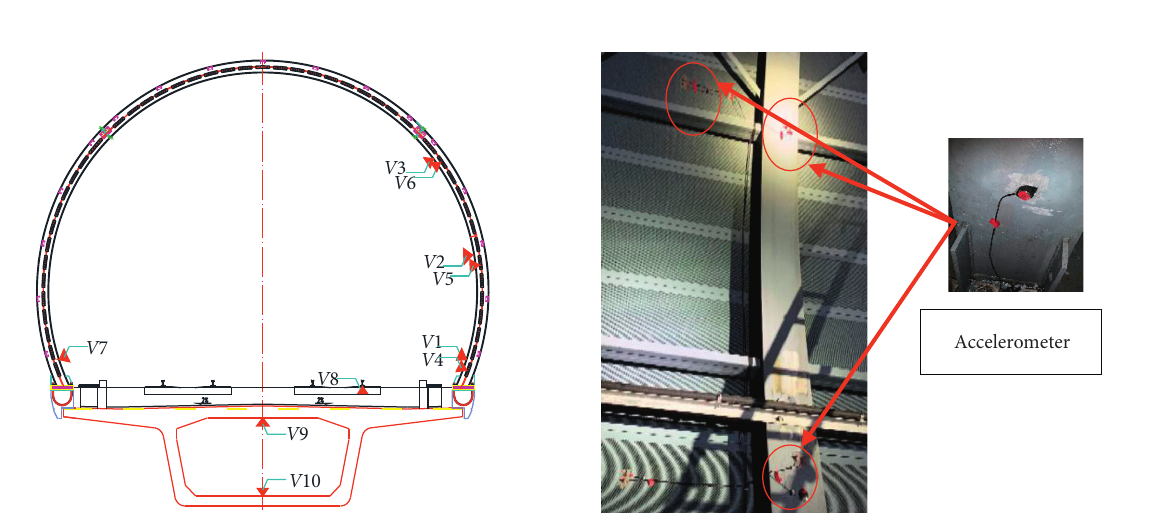
Figure 2: Test diagram of the FESB.